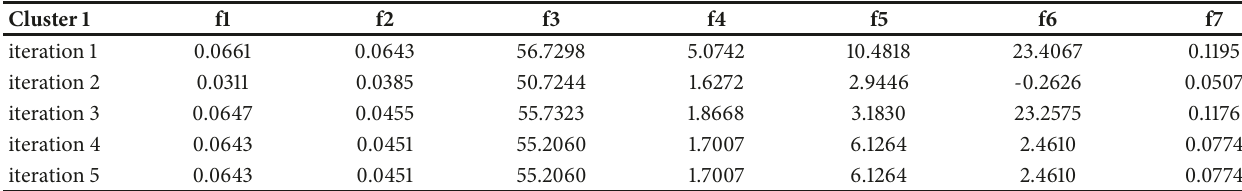
Table 8: Iterations for Cluster